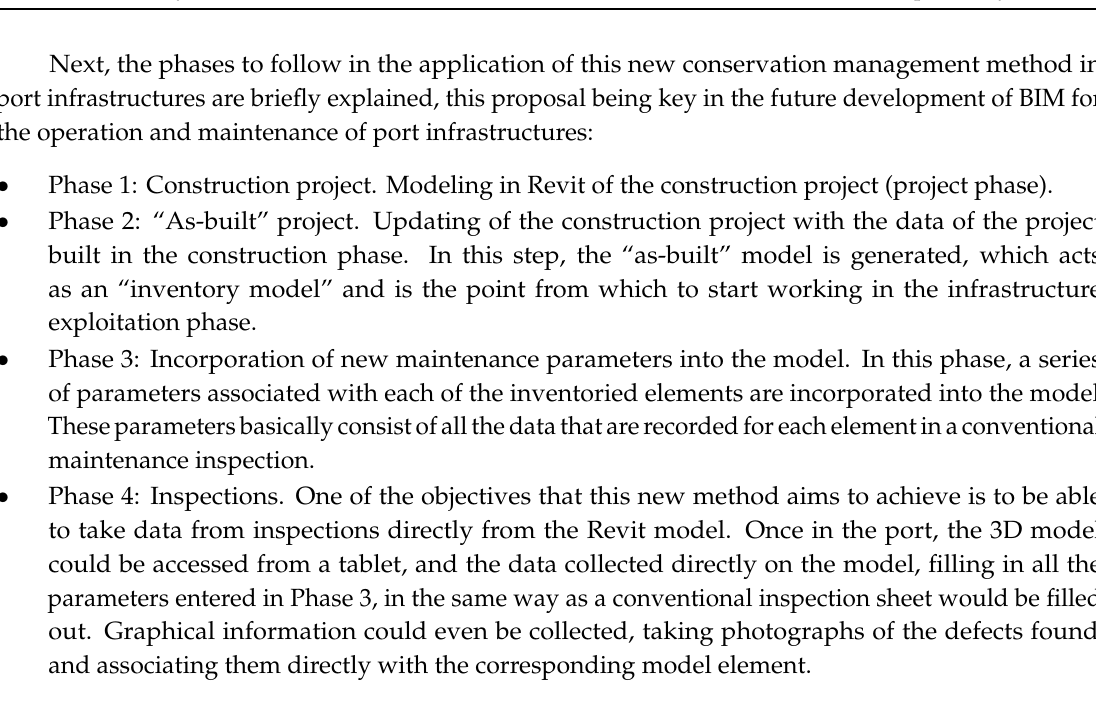
Table 1. Advantages and disadvantages of BIM method in comparison to traditional ones.